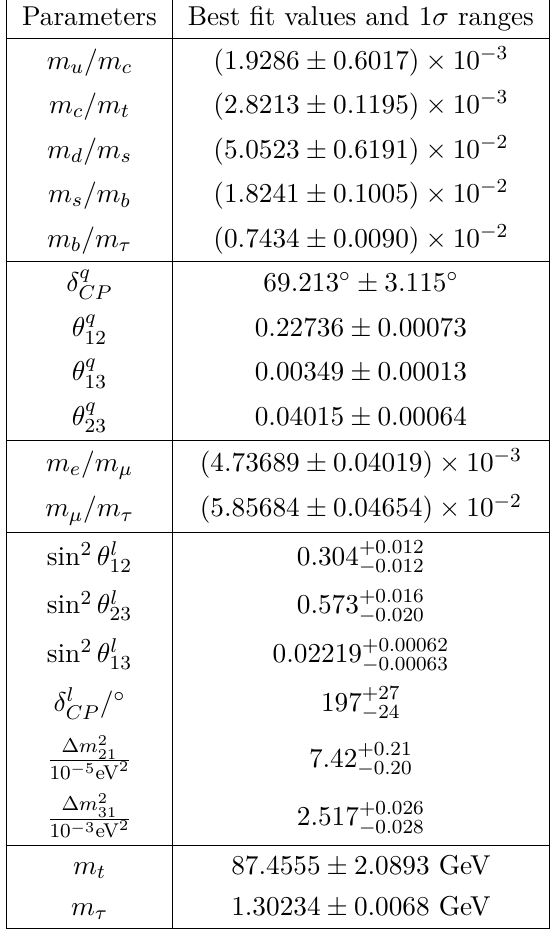
= 10 TeV and tan β = 10 , ¯ η = SUSY b